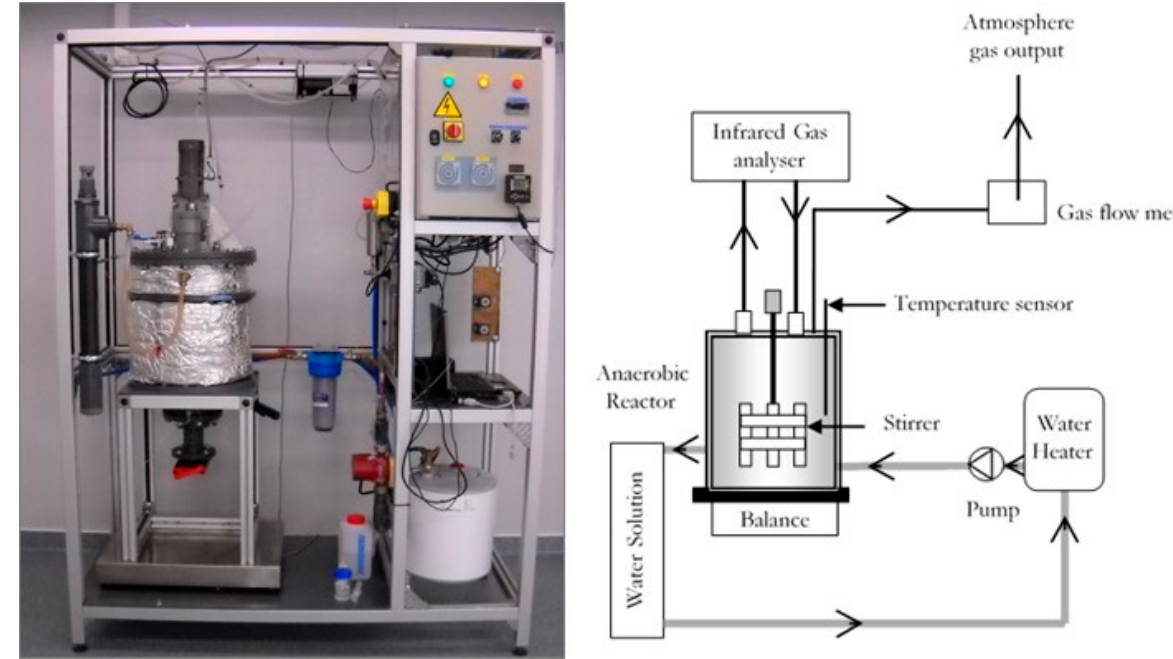
Figure 1. Schematic view of the anaerobic digester pilot.